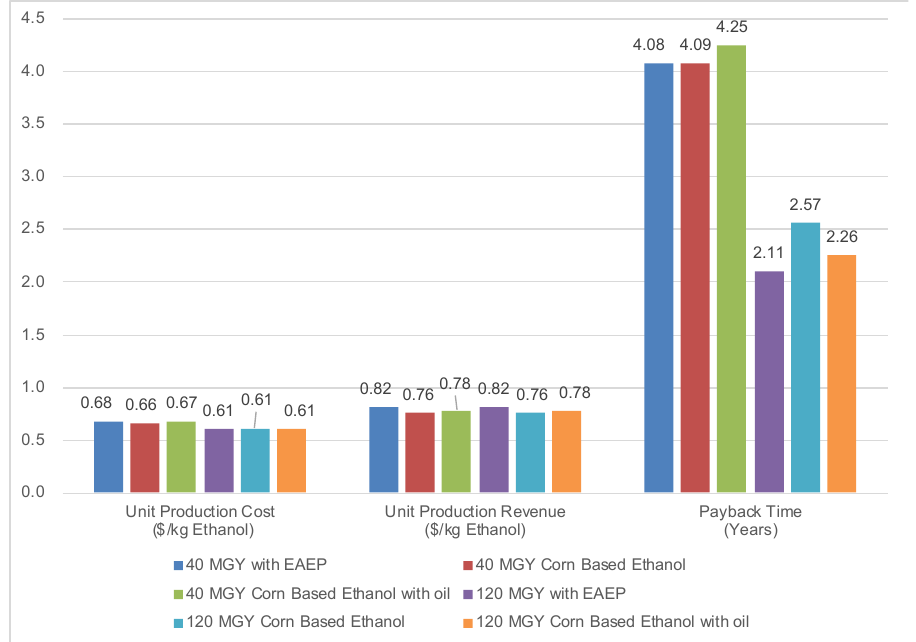
Figure 6. Profitability analysis for integrated corn-soy ethanol fermentation processing. Scenarios include a 40 million gallon per year (MGY) ethanol plant with or without corn oil separation, a 120 MGY ethanol with or without corn oil separation, and a 40 or 120 MGY ethanol plant, without corn oil separation but with EAEP products used for fermentation.